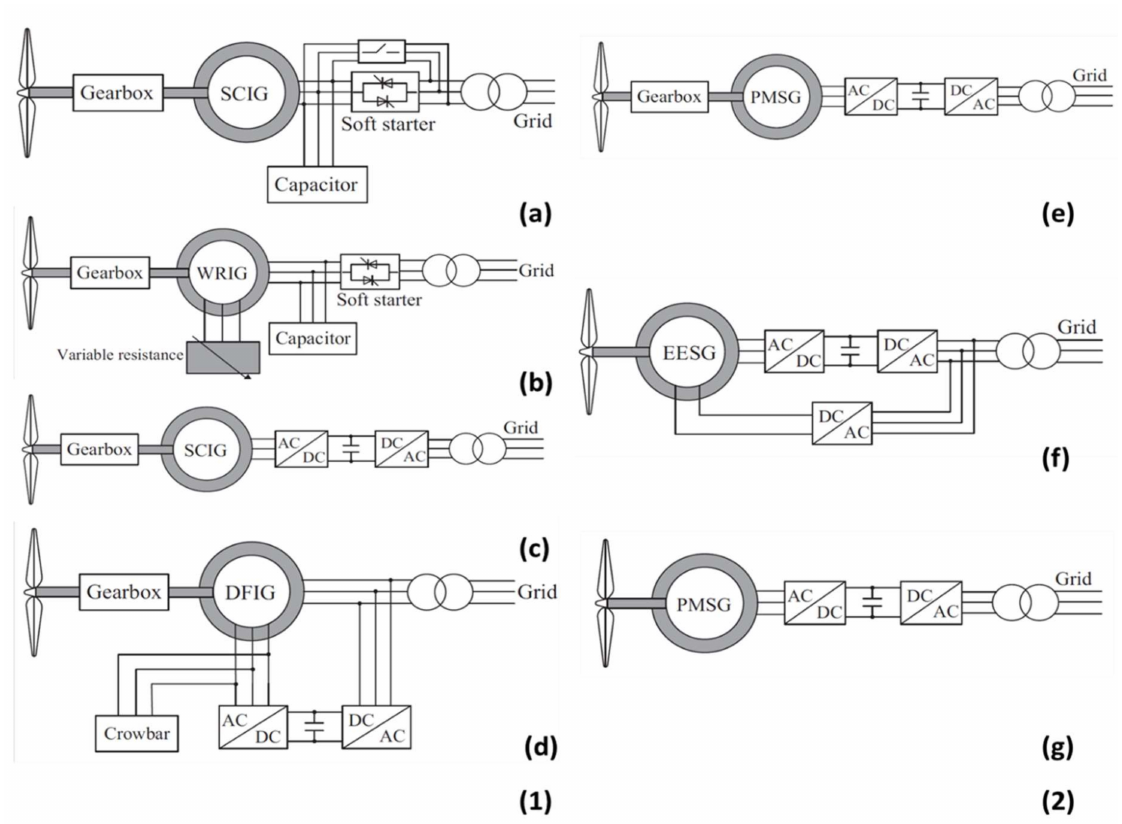
Figure 20. Power electronics converters for different types of generators: ( 1 ) induction (IG); ( 2 ) synchronous (SG), ( a ) fixed- speed squirrel-cage (SC), ( b ) limited variable-speed wound rotor (WR), ( c ) variable-speed squirrel-cage (SC), ( d ) variable- speed wound rotor (WR) or doubly fed (DF), ( e ) variable-speed indirect permanent magnet (PM), ( f ) variable-speed direct external excitation permanent magnet (EEPM), and ( g ) variable speed indirect permanent magnet (PM) with full-power electronics facilities (adapted from